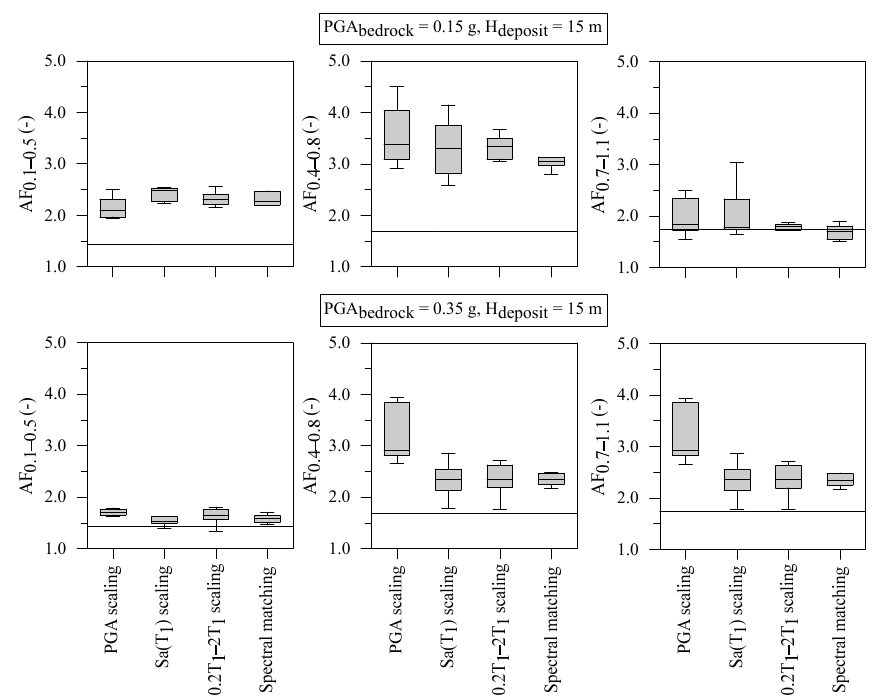
Figure 11. Box plots of AFs for a deposit thickness equal to 15 m and VS 1 (z), considering 4 selection strategies for the input motions. The constant value retrieved from EC8 (thin black line) refers to ground type E.